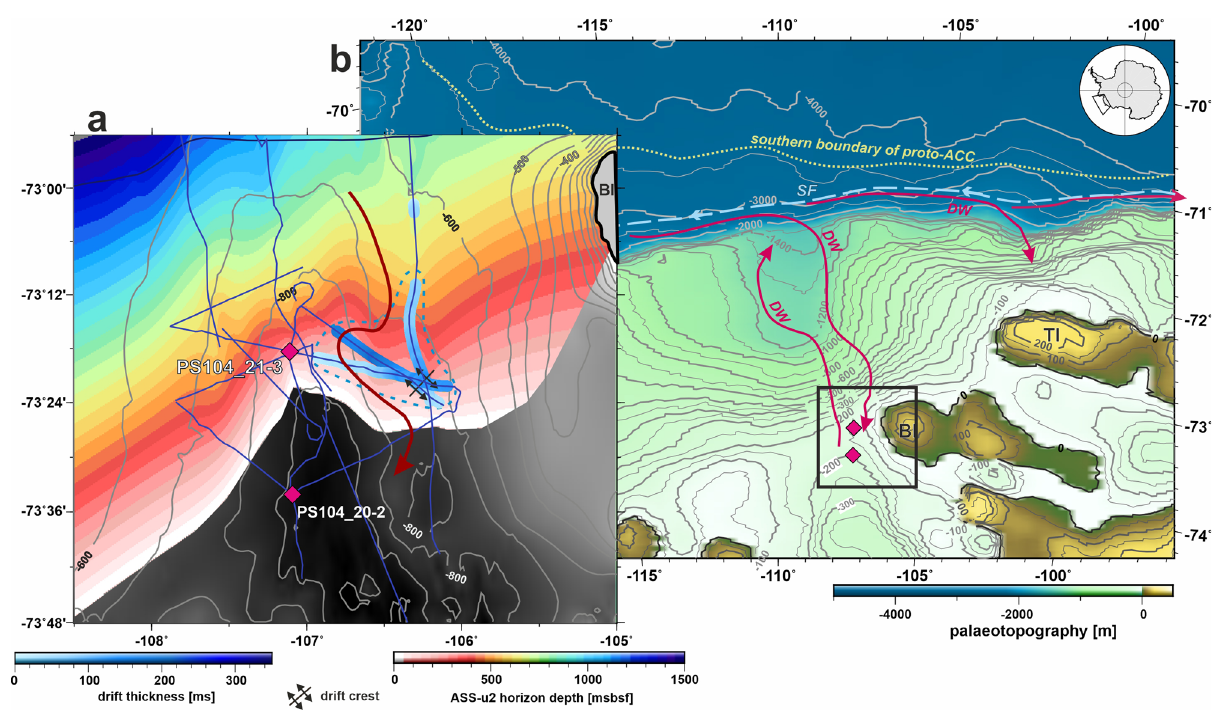
Fig. 3 Palaeobathymetry and inferred palaeocirculation. a Depth of seismic horizon ASS-u2 (in ms TWT below sea fl oor) and thickness of the imaged sediment drift lying on top of horizon ASS-u2 (in ms TWT). Dashed blue line shows inferred outline of the interpreted sediment drift. The red arrow shows the schematic deep water pathway inferred for the latest Eocene to earliest Oligocene. Thin blue lines show the location of seismic re fl ection pro fi les (for location of seismic lines shown in Figs. 2 and 5 see Fig. 1). Grey isolines and shaded area show the present day bathymetry with depths (m) labelled 78 . Magenta diamonds mark locations of Sites PS104_21-3, where Early Oligocene sediments were retrieved 38,72 , and PS104_20-2, where Late Cretaceous to Late Eocene (or younger) deposits were retrieved 36 . BI = Burke Island. b Minimum palaeotopography/palaeobathymetry for the ASE 22,41,82 . The box shows the area enlarged in (a). Magenta diamonds show the locations of Sites PS104_21-3 and PS104_20-2 in accordance with the palaeotopographic/ palaeobathymetric reconstruction by Paxman, et al. 22 and Hochmuth, et al. 41 . Arrows/lines schematically show the inferred pathways/location of deep water DW (red), potential slope front SF (dashed light blue), and the southern boundary of the proto-ACC the eastward rising fl ank of seismic horizon ASS-u2 with the shallowest and thickest part in the southeast (the drift crest) (Fig. 2). The drift shows thinning towards the north and west. transport (Fig. 2, open circles with dots indicate a fl ow path out of the fi gure plane, and 3, red arrow) with the Coriolis effect enhancing deposition on the left-hand side 33,43 , i.e., the same fl ow direction as today ’ s CDW. The overall form of the sediment drift in fl uences the present-day seabed morphology, as documented in the mounded structure observed at the sea fl oor on seismic pro- fi les AWI-20170012 (CDPs 1550 to 2100) and AWI-20100137 (CDPs 600 to 1500) (Fig. 2).